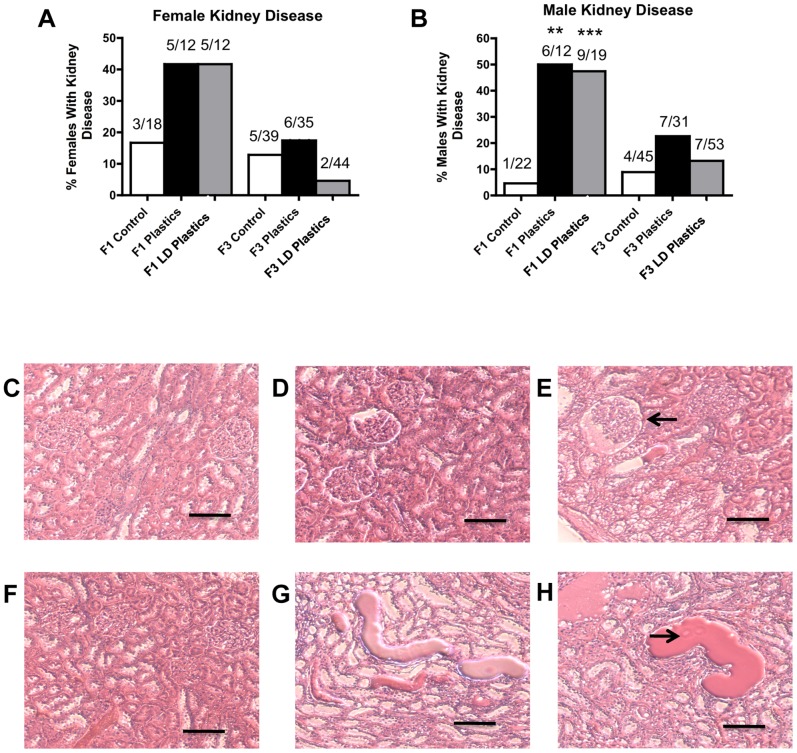
Adult-onset kidney disease in males or females from control, plastics and lower dose(LD) plastics (BPA, DEHP and DBP) lineages. Percentages of females (panel A) and males (panel B) with kidney disease in F1 and F3 generations are presented. The actual number of diseased rats/total number of rats in each group are shown above the respective bar graphs (** P<0.01; *** P<0.001). Representative micrographs (Scale bar  = 200 μm) showing histopathology images of adult-onset transgenerational kidney disease in F3 generation plastics (panels D and G) and lower dose (LD) plastics lineages (panels E and H) compared to F3 control lineage (panels C and F). Kidney sections showed Bowman's capsule abnormality and proteinaceous fluid filled cysts (arrows).